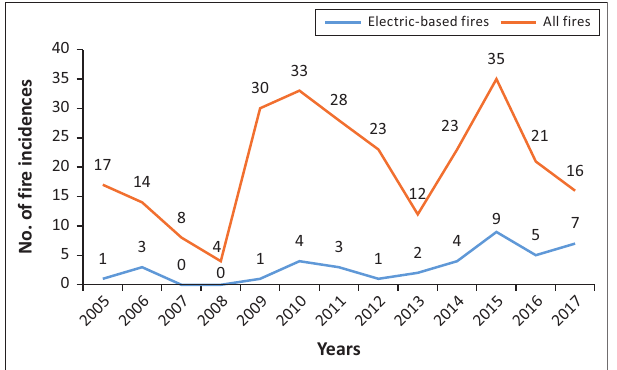
FIGURE 11: Increasing number of electric-based fires occurring in study